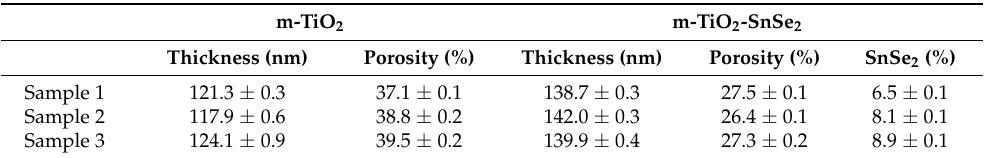
Table 1. Thickness, porosity and SnSe 2 loading measured by ellipsometry for three m-TiO 2 and m-TiO 2 -SnSe 2 films (Samples 1, 2, and 3).